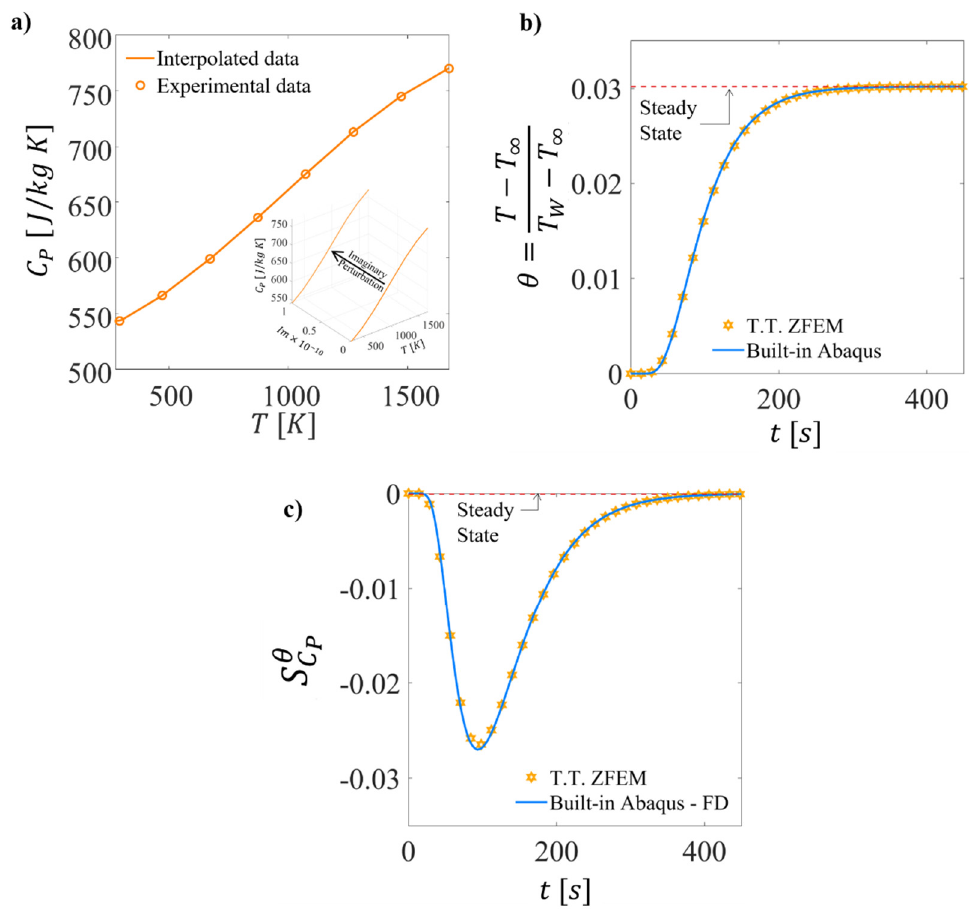
Figure 8. ( a ) Temperature-dependent specific heat of Ti64. Experimental data obtained from [90]. The inset shows the original and the perturbed property in the T − C P − i space; ( b ) dimensionless temperature history of fin tip for temperature-dependent specific heat; ( c ) sensitivity of θ to specific temperature-dependent specific heat. Yellow star, sensitivity using Transient Thermal ZFEM, blue square, sensitivity using 1% FD and Abaqus built-in element solution, black dashed line, steady-state solution.